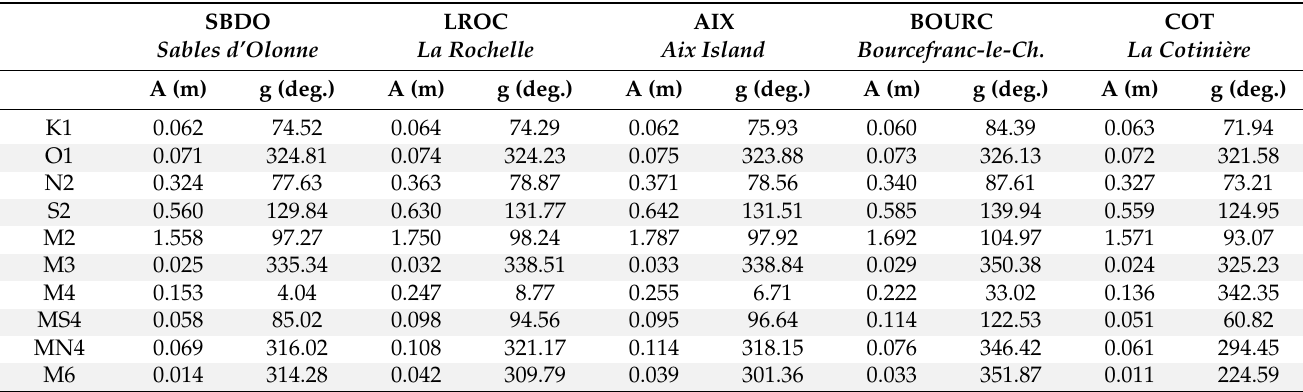
Table 1. Amplitude (A) and phase lags (g) of the principal tidal constituents, computed at 5 stations in the Pertuis Charentais area. Shallow water tidal waves are highlighted by the black